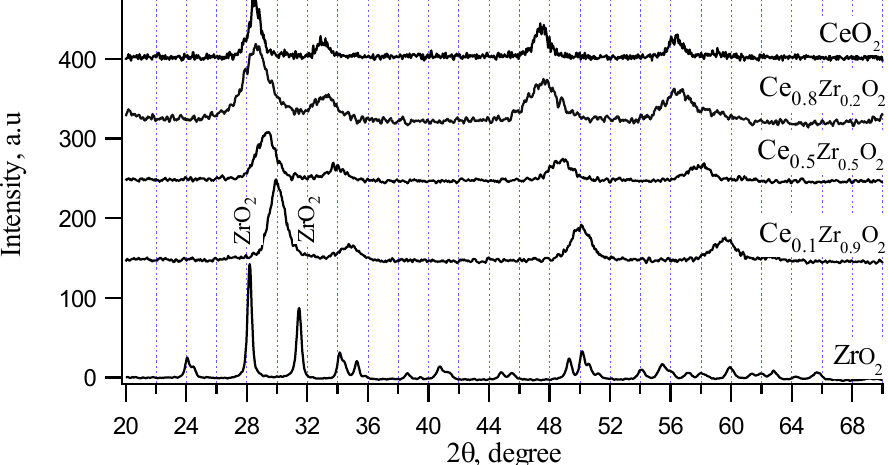
Figure 1. X-ray patterns of CeO 2 -ZrO 2 chemical